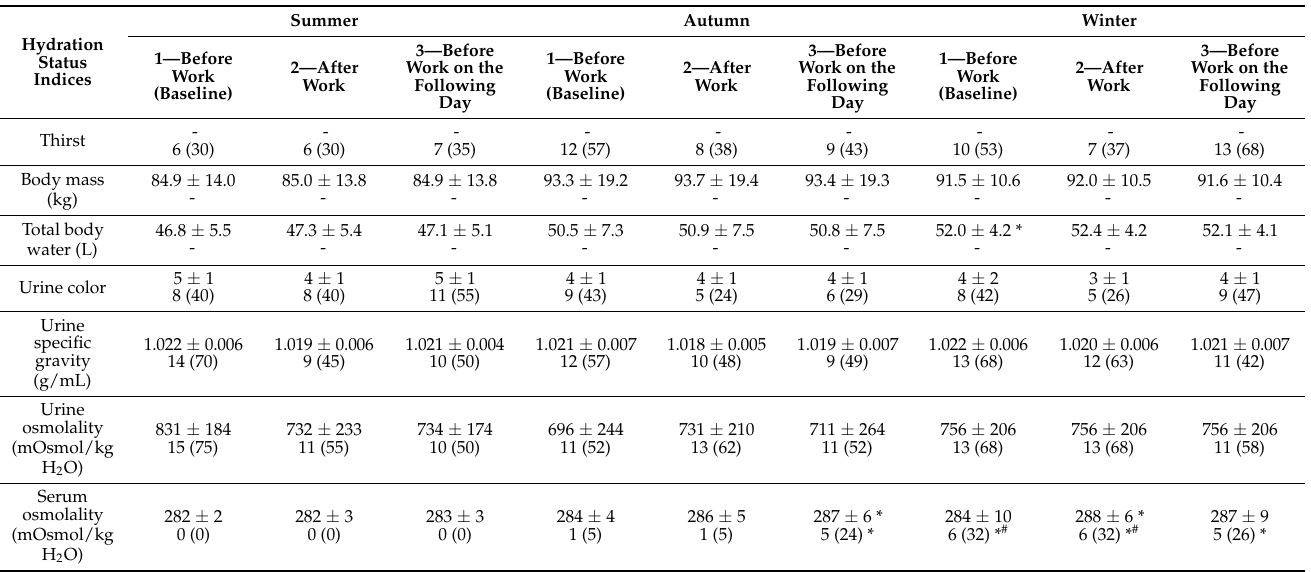
Table 4. Hydration status indices depending on the season of the year: mean ± standard deviation and the number (percentage) of dehydrated workers (where